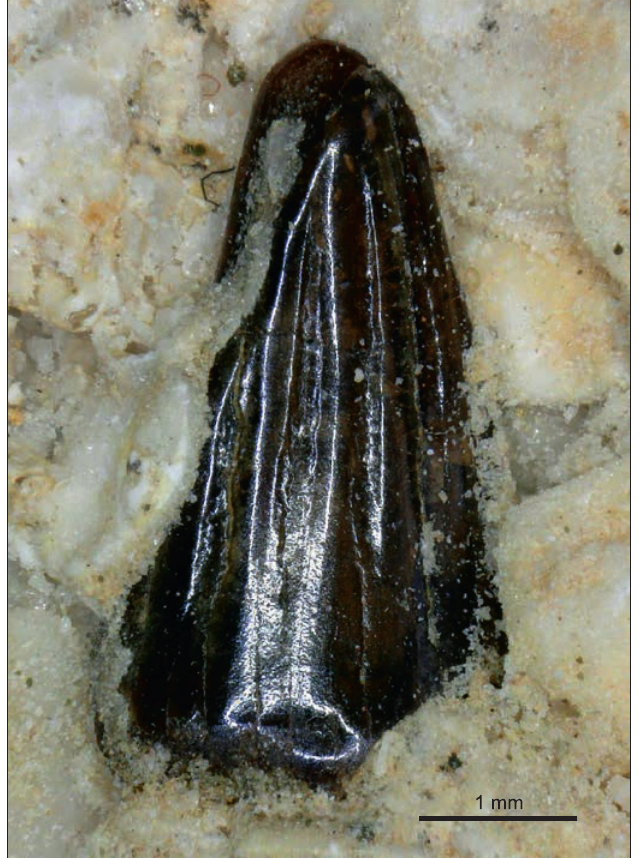
Fig. 10. Isolated tooth crown ZPAL V. 69/1 (“ZPAL V-KRZ/33”) from the Kimmeridgian of Krzyżanowice, pertaining to an indeterminate vertebrate, incorrectly identified as Machimosaurus sp. by Tyborowski and Bła że jow- ski